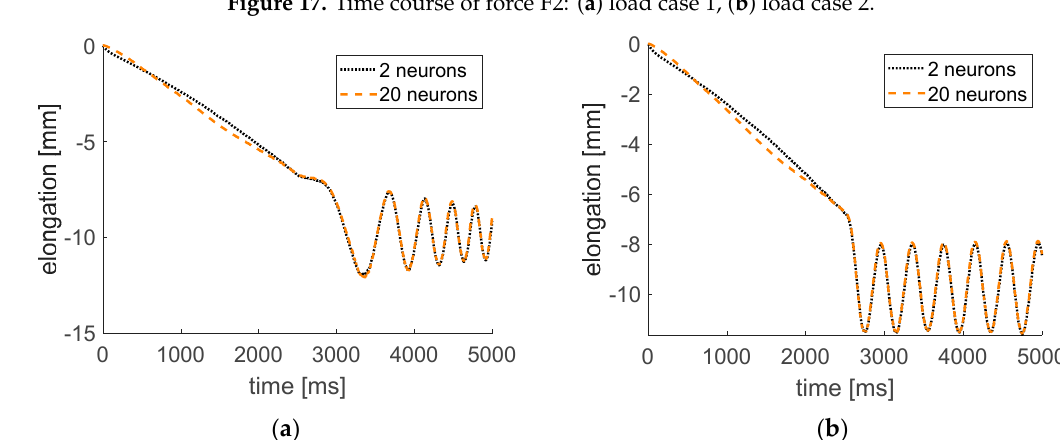
Figure 17. Time course of force F2: ( a ) load case 1, ( b ) load case 2.